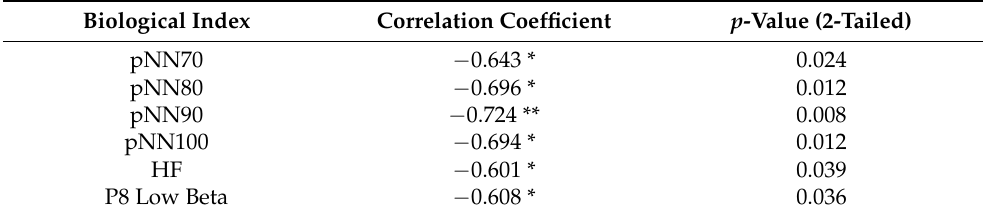
Table 15. Correlation coefficients between the difference in number of errors between the tasks and the mean values of biological indexes during Rest2 (* correlation is significant at the 0.05 level; ** correlation is significant at the 0.01